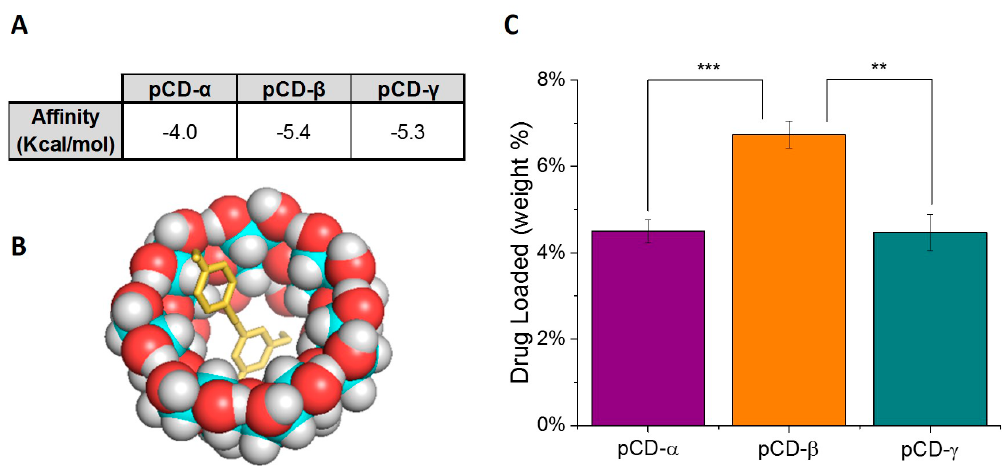
Figure 1. Beta-cyclodextrin demonstrates the highest a ffi nity for resveratrol loading. ( A ) Estimated a ffi nity binding strengths (a ffi nity, Kcal / mol) for cyclodextrin (CD) / resveratrol complex, developed using PyRx modelling software. ( B ) 3D conformer representing the CD / resveratrol complex model. The 3D image depicts simulated resveratrol complexing with a single beta-CD molecule. ( C ) Loading ratios of resveratrol into pCD disks. Experimental studies indicated beta-CD polymer had the highest loading of resveratrol at 6.7 weight%. ** represents p < 0.01 and *** represents p <